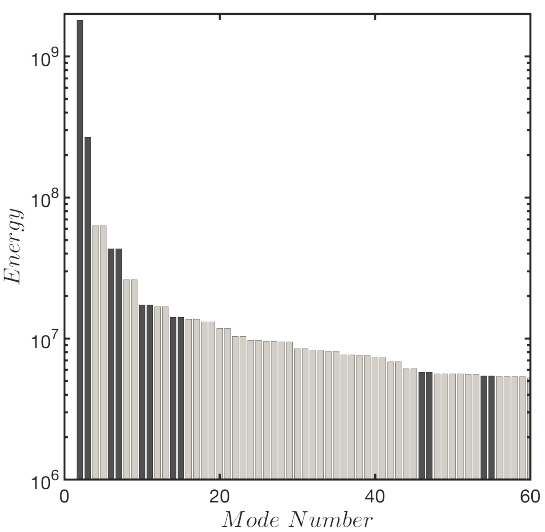
Figure 10. The energy of the first 60 dynamic modes. Robust modes are shown in the dark color. Note that robust modes are not those with the highest